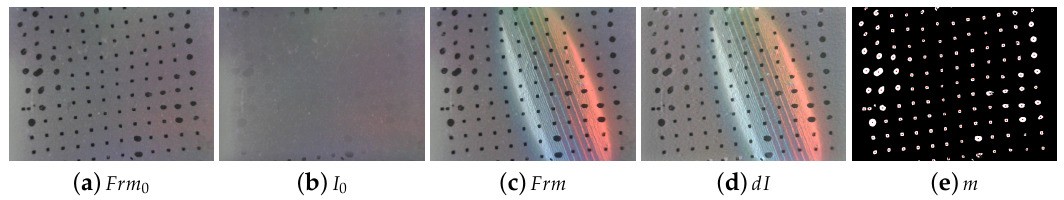
Figure 5. The procedure of segmenting and locating the markers in the GelSight images. ( a ) the initial GelSight frame Frm 0 when noting is in touch; ( b ) the low-pass Gaussian filtered image I 0 from Frm 0 , where only the color background is left; ( c ) a GelSight frame Frm when the sensor is touching a cylinder; ( d ) the image dI after subtracting the initial background I 0 from the current frame Frm (color is normalized for display purpose); ( e ) the mask of the markers after thresholding on dI . The red dots denotes the centroids of the markers.